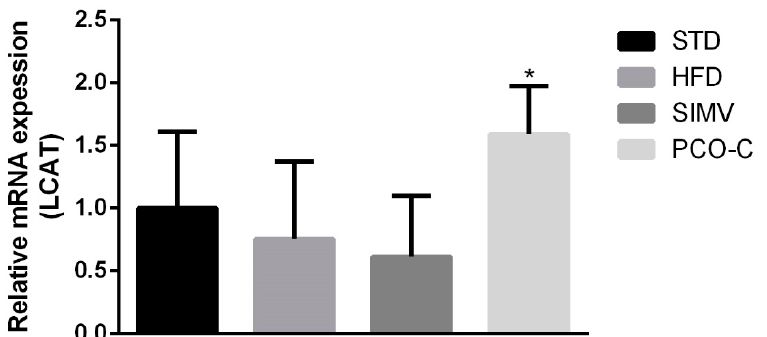
Figure 4. Effect of PCO-C on the transcription levels of liver LCAT (lecithin-cholesterol acyl transferase)